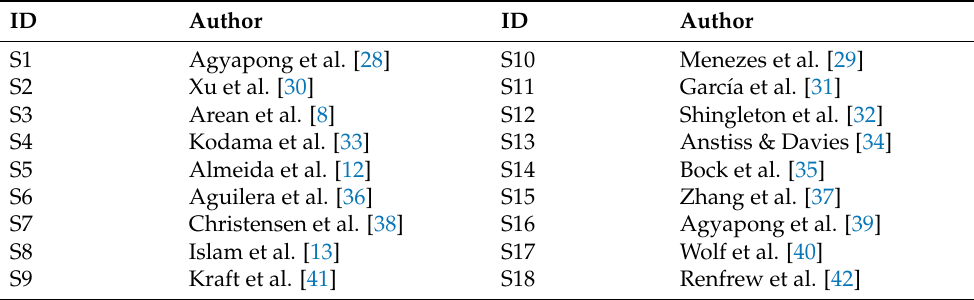
Figure 3. Article Selection Flow [27]. Table 1. References of Articles Selected for Literature